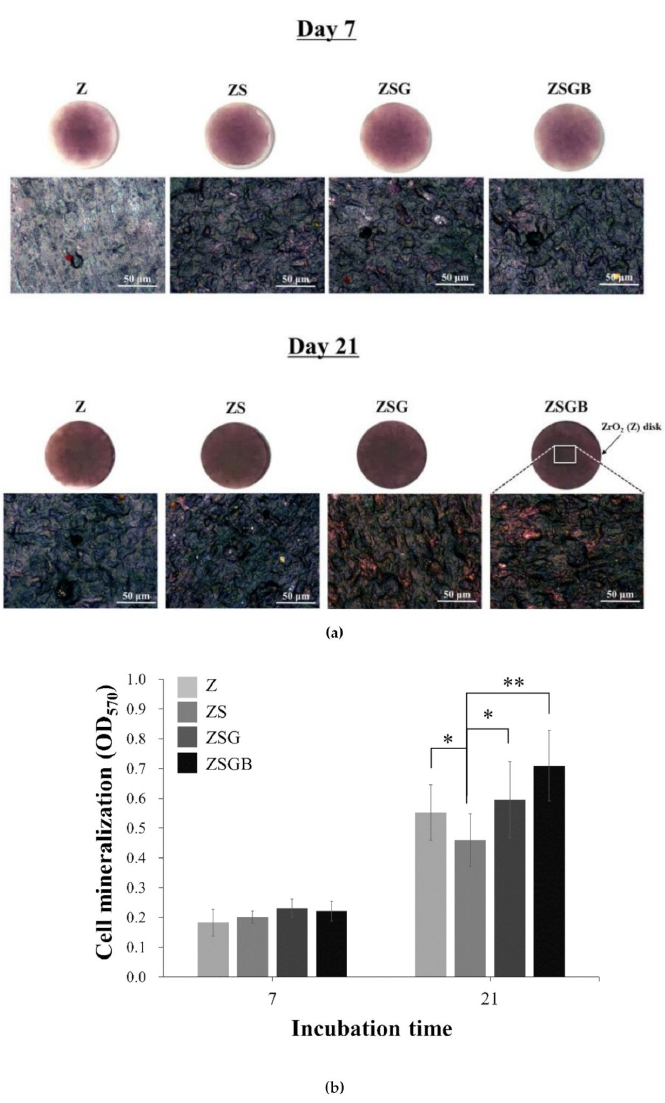
Figure 6. Cell mineralization analysis results, in terms of Alizarin red S staining, of the test specimens after 7 d and 21 d of incubation: ( a ) qualitative observation (upper row: zirconia disk; lower row: higher magnification of upper row); ( b ) quantitative analysis (* p < 0.05; ** p <